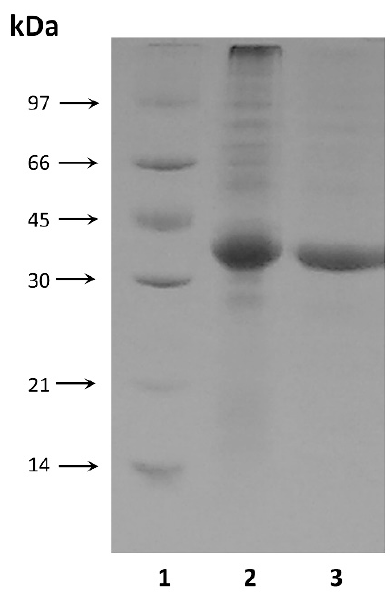
Figure 2. SDS-PAGE analysis: 1—protein molecular weight marker; 2—MrAII in cell free homogenate at a concentration of 20 µ g; 3—purified MrAII at a concentration of 11 µ